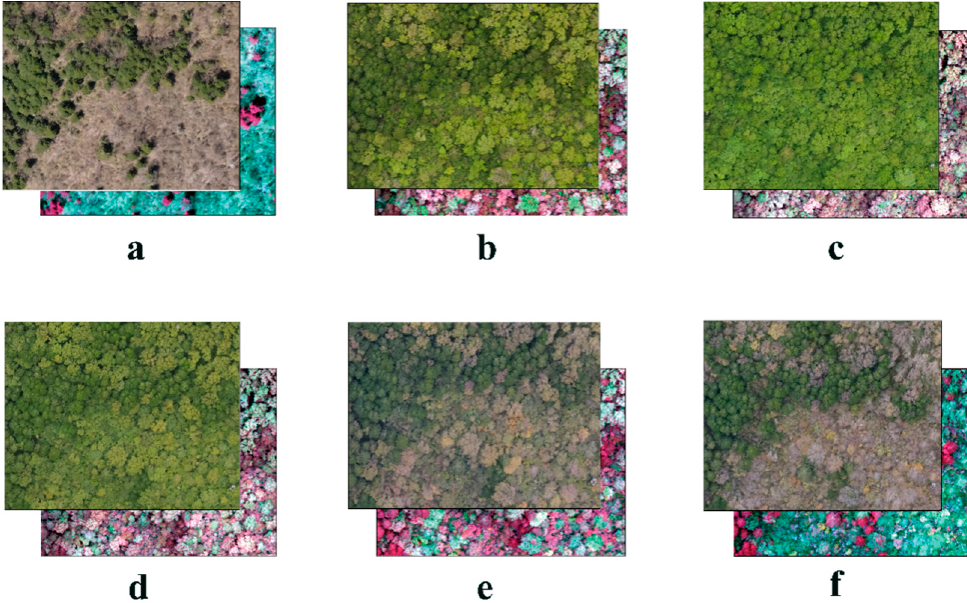
Figure 2. RGB and multispectral imagery collected by drones for di ff erent months: ( a ) April 21, ( b ) May 23, ( c ) June 17, ( d ) August 27, ( e ) September 27, and ( f ) October 27.